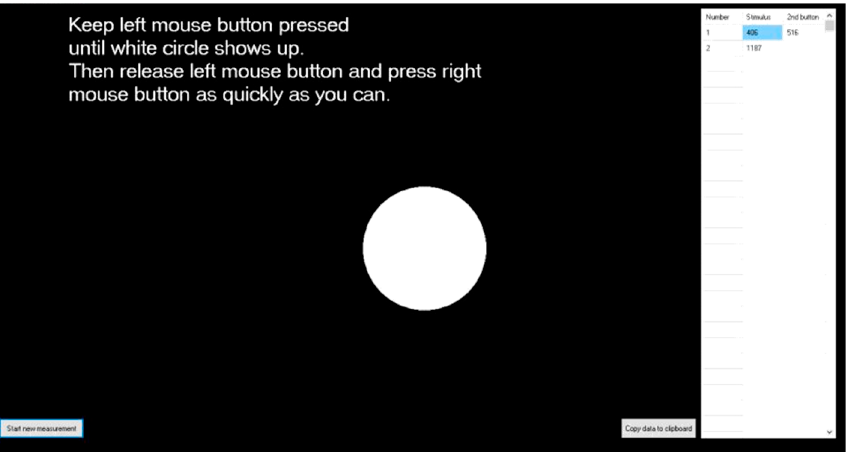
Figure 4. Screen capture of reaction time (RT) test.